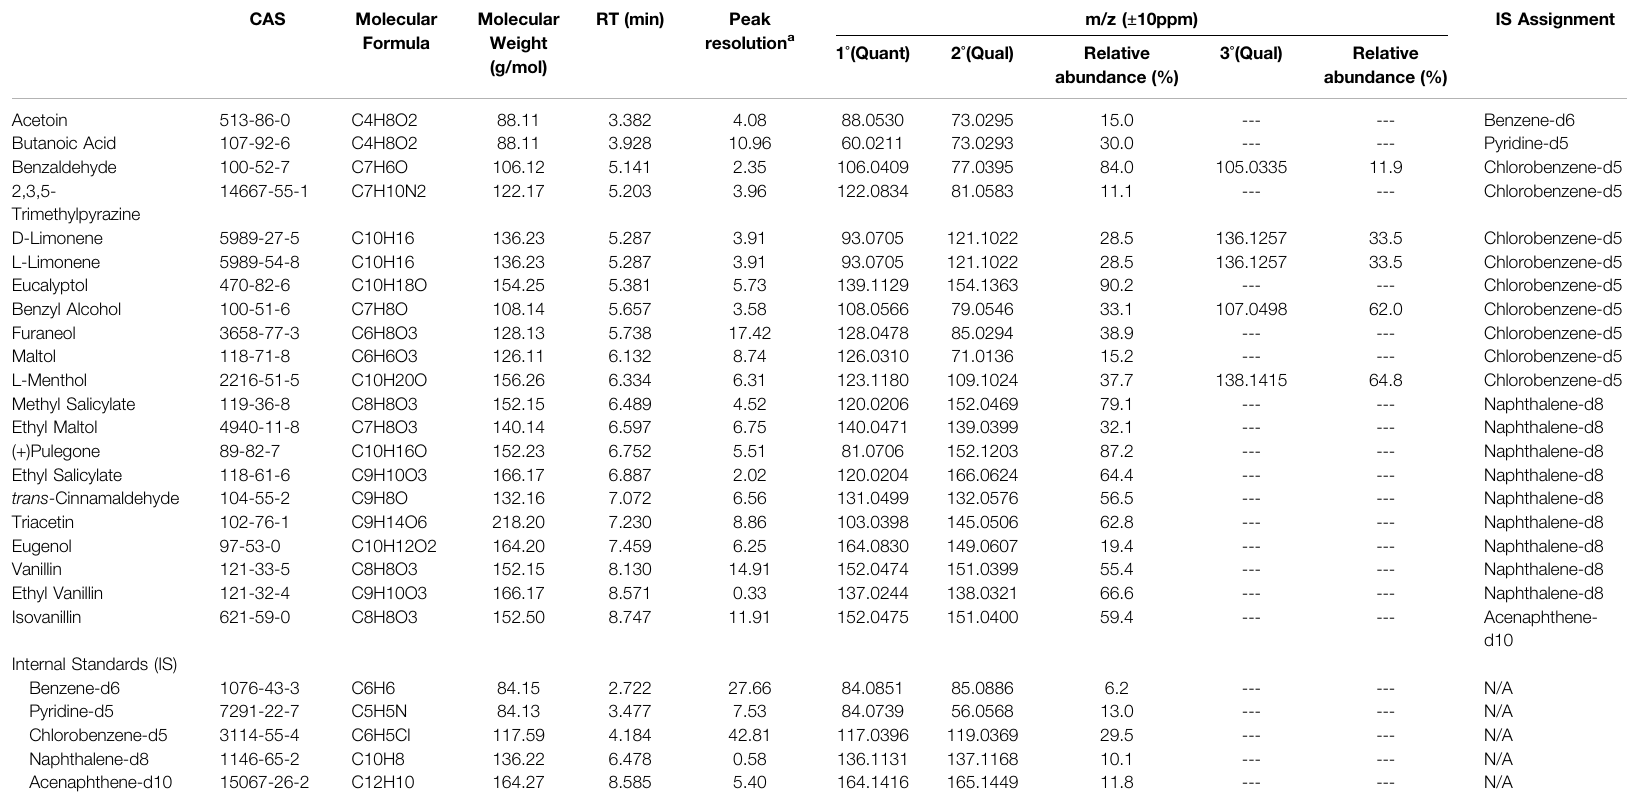
TABLE 1 | Retention time, Resolution, Quantitation and Qualitative Ions and Internal Standard Assignments for Twenty Flavoring